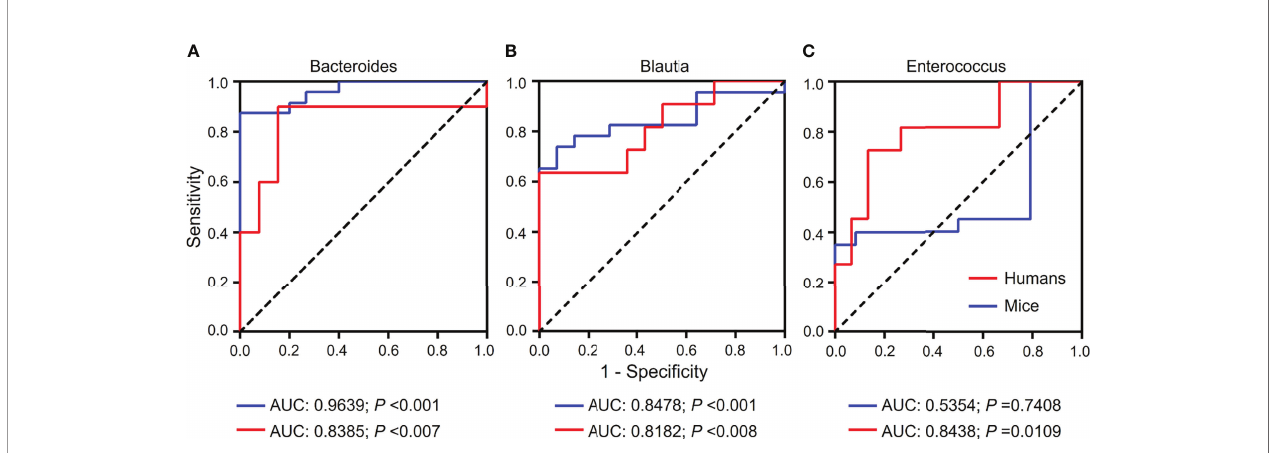
FIGURE 5 | Receiver-operating characteristic (ROC) curves for the diagnosis of granulomas or fi brosis in S. japonicum- infected and uninfected hosts. ROC curves using three bacteria including Bacteroides (A) , Blautia (B) and Enterococcus (C) were plotted for the diagnosis. The area under the ROC curves (AUC) was calculated. The rate of identi fi ed outliers of Bacteroides is 10% and the rate of identi fi ed outliers of Blautia and Enterococcus is 5%.